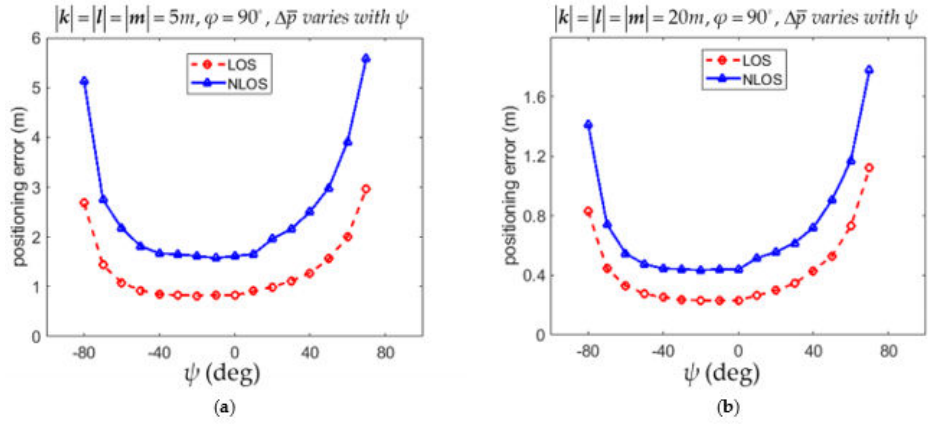
Figure 11. Variation of 3D RMSPE ∆ p with angles ψ for the LOS and NLOS conditions. ( a ) The environment of 5 m × 5 m × 5 m . ( b ) The environment of 20 m × 20 m × 20 m .